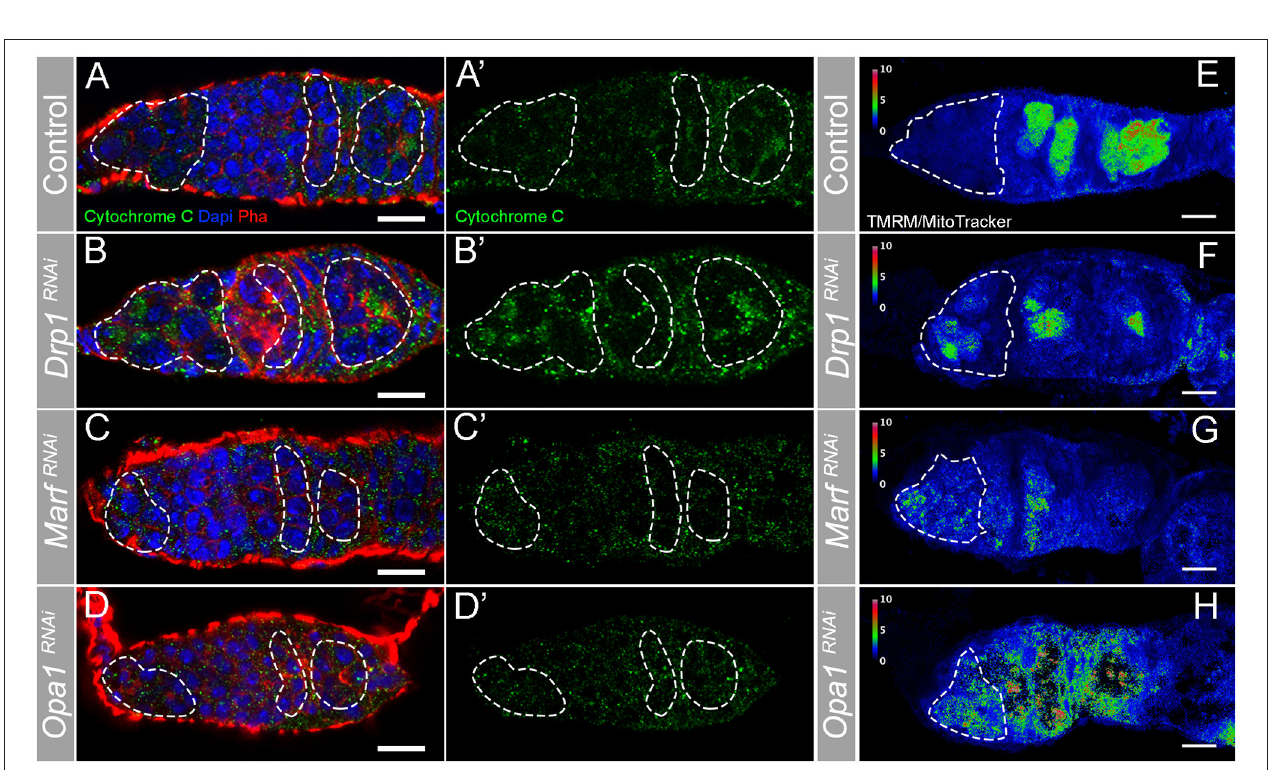
FIGURE 2 | presence of Hts-labeled spectrosome (1B1, pink). The dashed white squares highlight GSCs, marked by asterisks. Arrowheads point to spectrosome of GSCs that are in contact with niche cells. Control germaria typically have 2–3 GSCs (A–A ′′ ,E) . Depletion of mitochondrial fission regulator Drp1 (B–B ′′ ,E) or mitochondrial fusion regulators Marf (C–C ′′ ,E) and Opa1 (D–D ′′ ,E) significantly decreases GSC number. Images shown are representative of Drp1 RNAi (v44156), Marf RNAi (v40478), and Opa1 RNAi (v106290) germaria. Nuclei and F-actin are labeled with DAPI (blue) and Phalloidin (Pha, red), respectively. Scale bars represent 10 µ m. (E) Quantification of the average number of GSCs ( ± SD) per germarium expressing the indicated RNAi lines in GSCs ( nos Gal4). Gray bars indicate the RNAi lines used in the following analyses for each of the mitochondrial dynamics regulators. Statistical significance vs. control was calculated using simple sample t -test. ** P